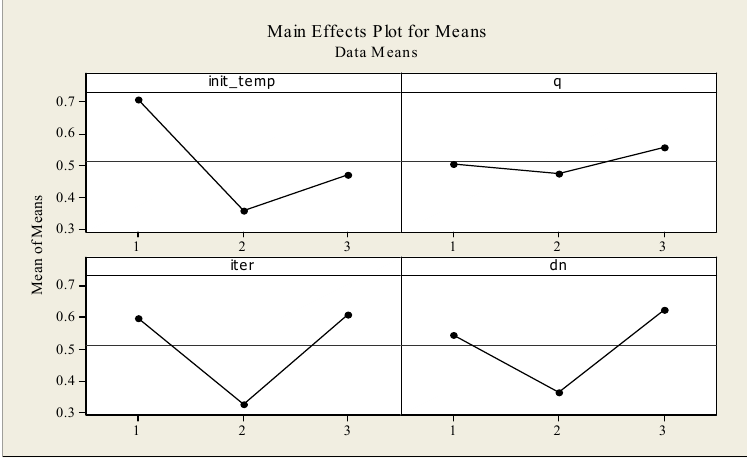
Fig. 4. The major effects of unpaired